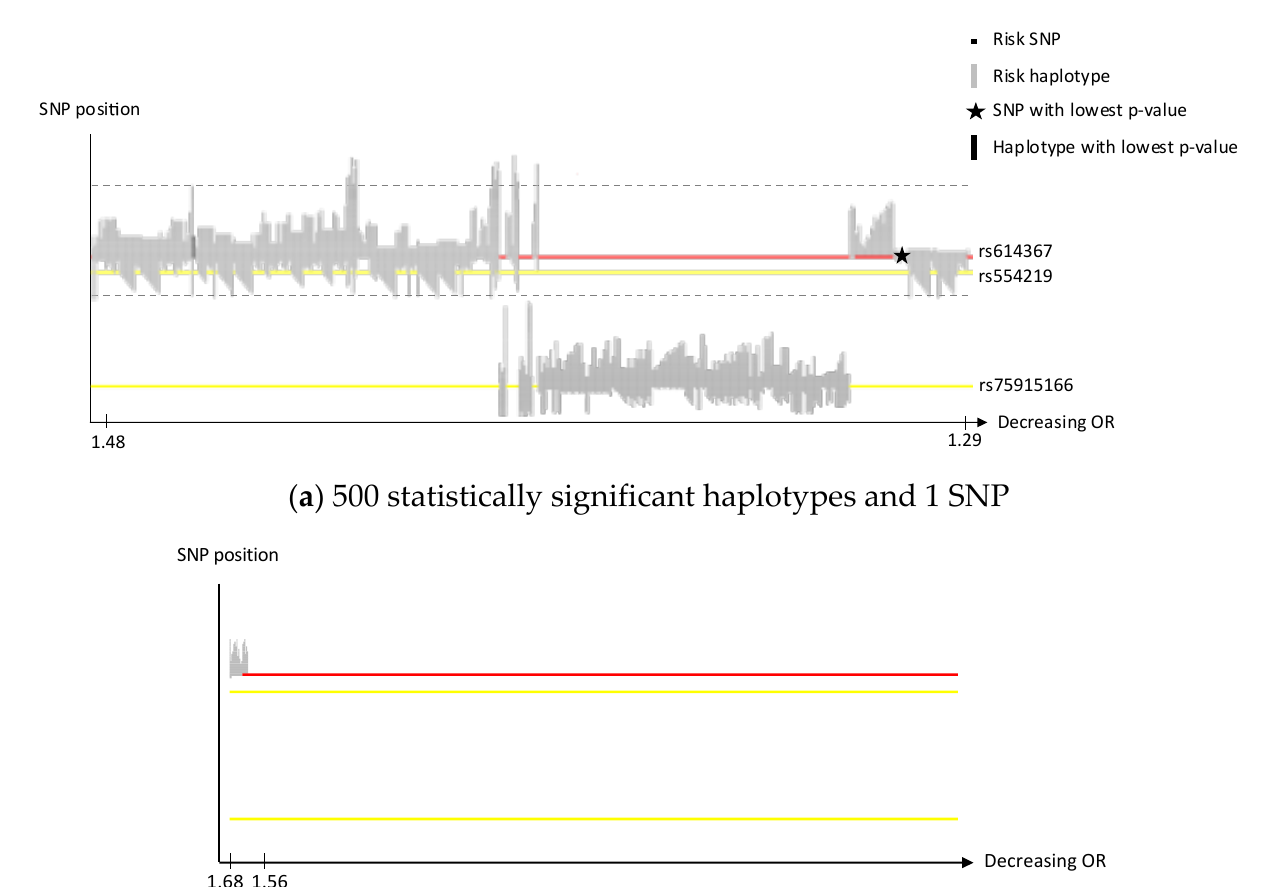
[32] Abbreviations: SNP = Single Nucleotide Polymorphism; MAF = minor allele frequency; OR = Odds Ratio; Ref. = Reference; SWE = result from present Swedish GWAS; BCAC = Previous published Oncoarray results from BCAC Collaboration. Reference panel GRCH37 for SNP positions. 3.3. Locus 11q13.3 We identified one significant SNP and 500 risk haplotypes (481 wdw 2-25, 19 wdw 50) in 11q13.3 (Tables S6 and S7). Similarly, as for Chr 10, their positional relation are illustrated in Figure 2a. According to the haplotype clusters two separate risk subloci were suggested in locus 11q13.3: sublocus 11q(a) on the red line with the only significant risk SNP rs614367 (Table 1) and sublocus 11q(b) on the bottom yellow line and the published BCAC SNP rs75915166 (Table 2). The haplotype with the lowest p-value (Table 1) within this locus includes the significant SNP but none of the two published BCAC SNPs. The vast majority of significant haplotypes showed a higher OR than the significant SNP. The significant haplotype of window size 50 with the lowest p-value (Table 1), is indicated by dashed lines in Figure 2a and involve only the upper sublocus. The analysis of familial samples resulted in a few statistically significant haplotypes, all around rs614367 and no